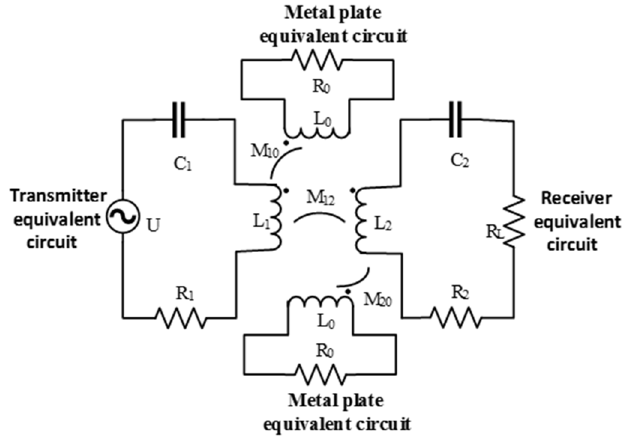
Figure 3. Equivalent circuit of wireless charging system with shielding plate.